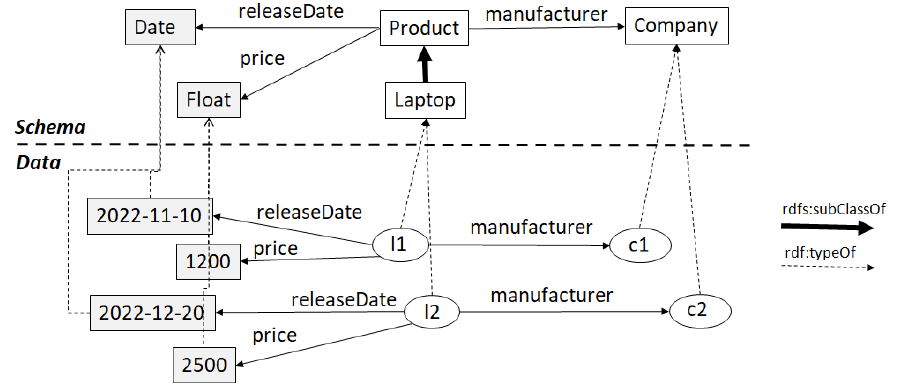
Figure 2. A KG about